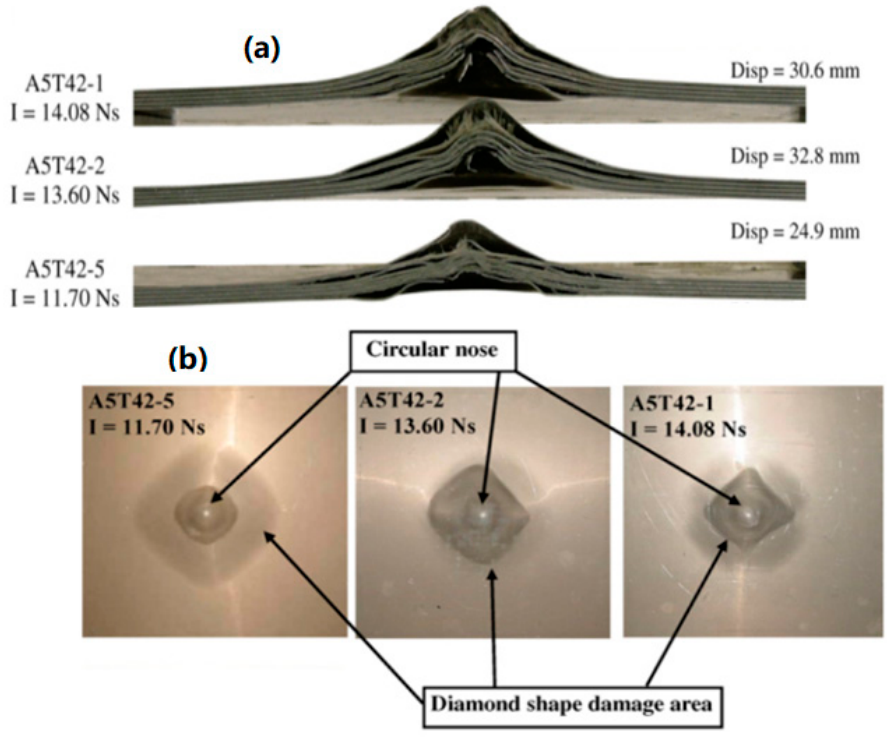
Figure 9. ( a ) Cross-section of sample in Ref. [31] ( b ) back face damage in Ref. [20].